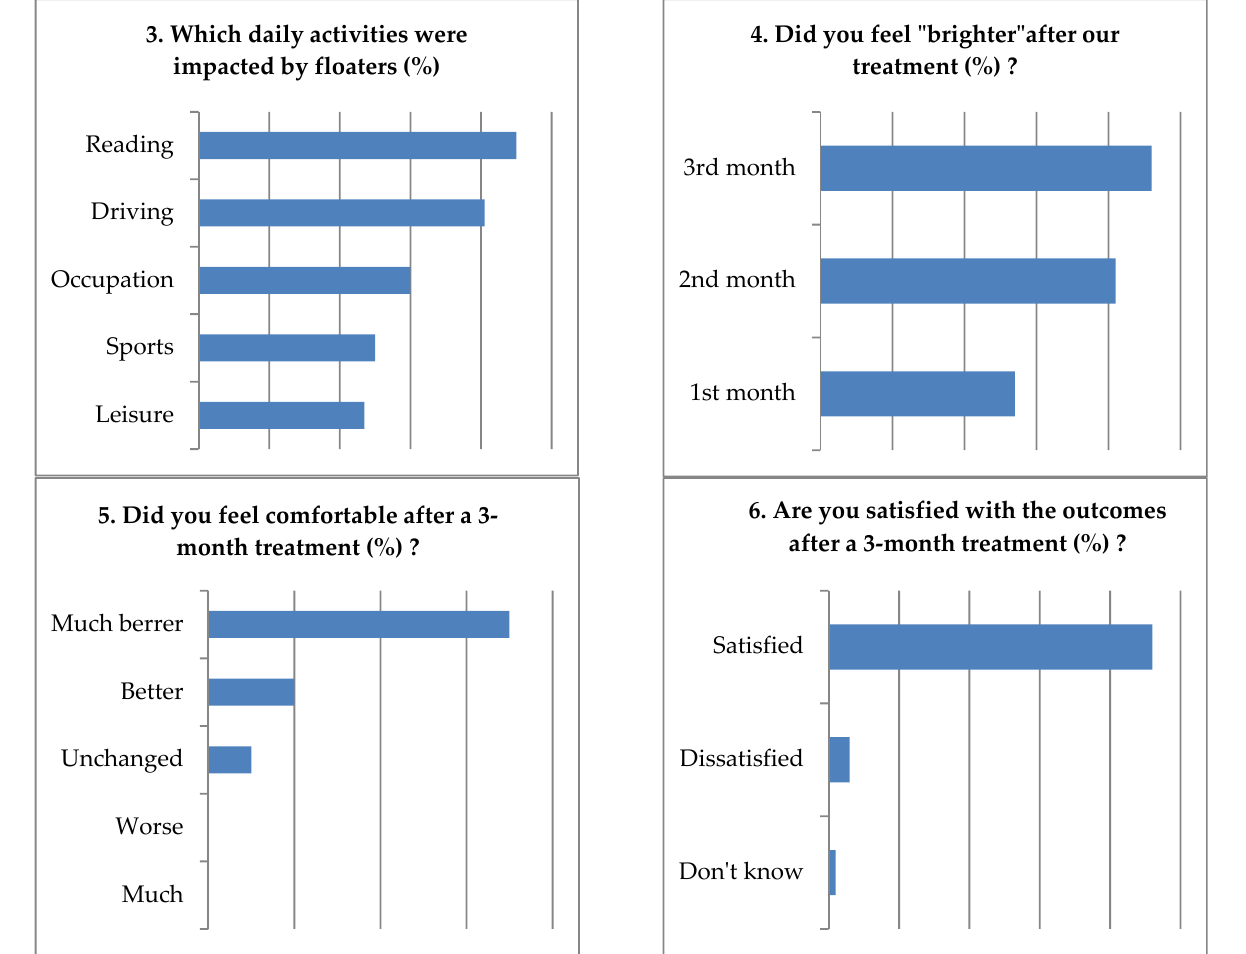
Figure 4. Results from the questionnaire on floaters-induced discomfort; the ocular floaters’ effect on daily activities and satisfaction were assessed.